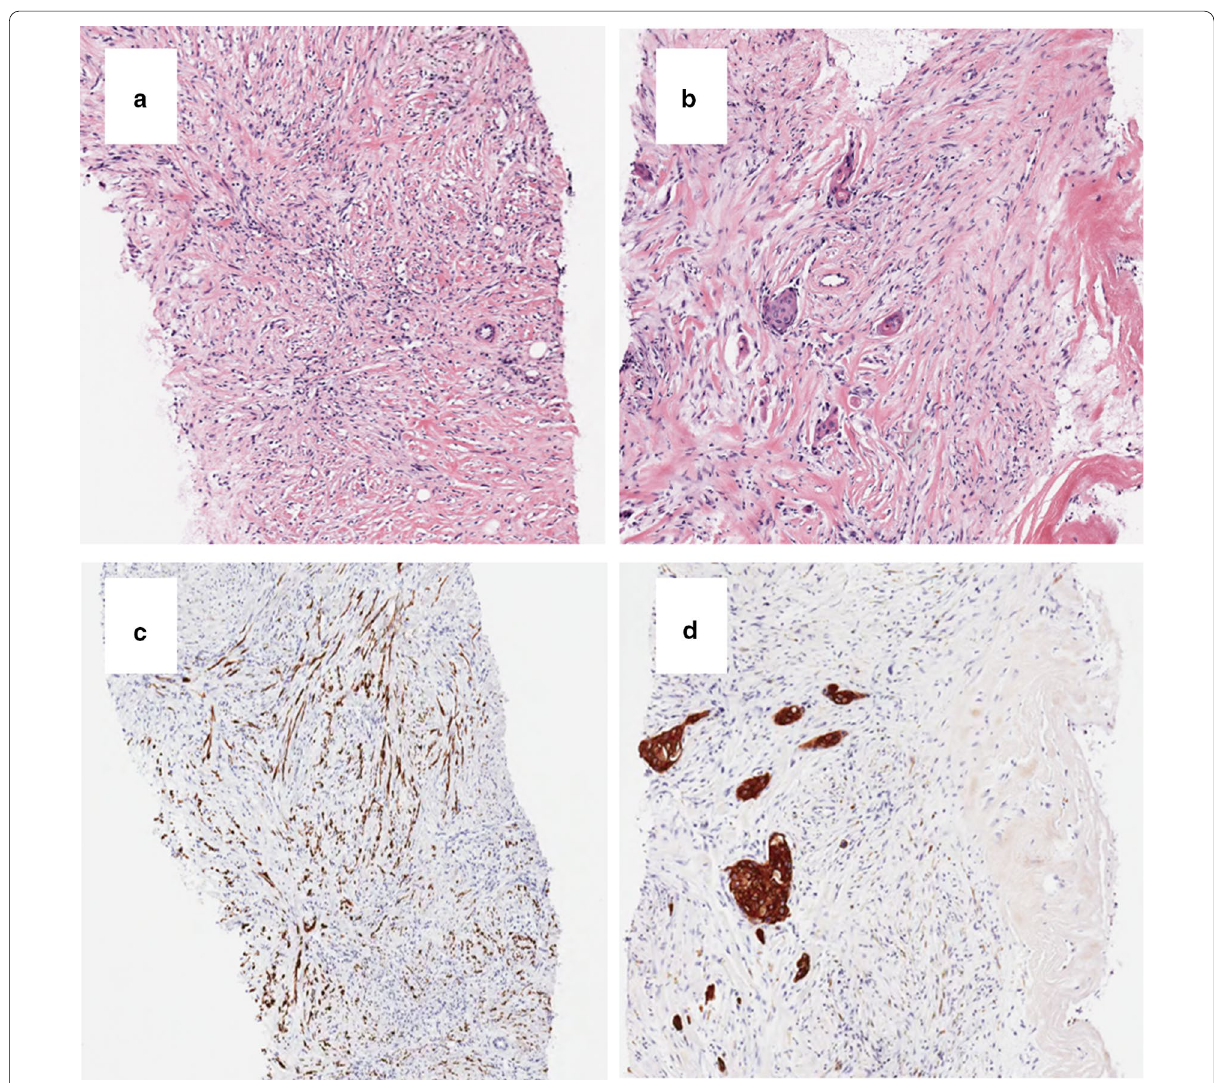
Fig. 4 Immunohistological findings of the biopsy. a Proliferation of fibroblast-like spindle cells was observed (H&E of squamous cell-like cells with low-grade atypical nuclei was observed (H&E positive in squamous cells (arrows